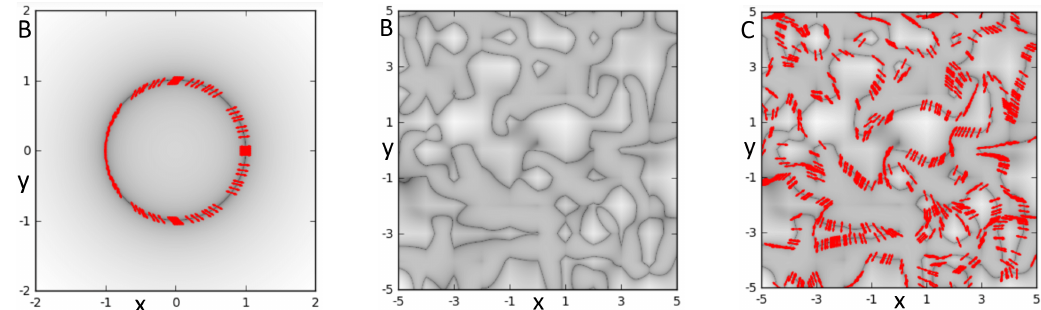
Figure 8: Curvature in the pure nematic model. A: Heat map of the time-dilation fac- tor γ [ Eq. (25) ] for the “disorder space” nematic manifold, with v in Eqs. (51a) and (51b). We note the singularities lie along the unit circle, with the collimation angle marked in red. Numerically computed null geodesics are displayed in Fig. 4 for this geometry. B: A heat map of the time-dilation factor for a random realization of pure nematic QGD. C: The heat map in B annotated to mark the colli- mation angles of the nematic